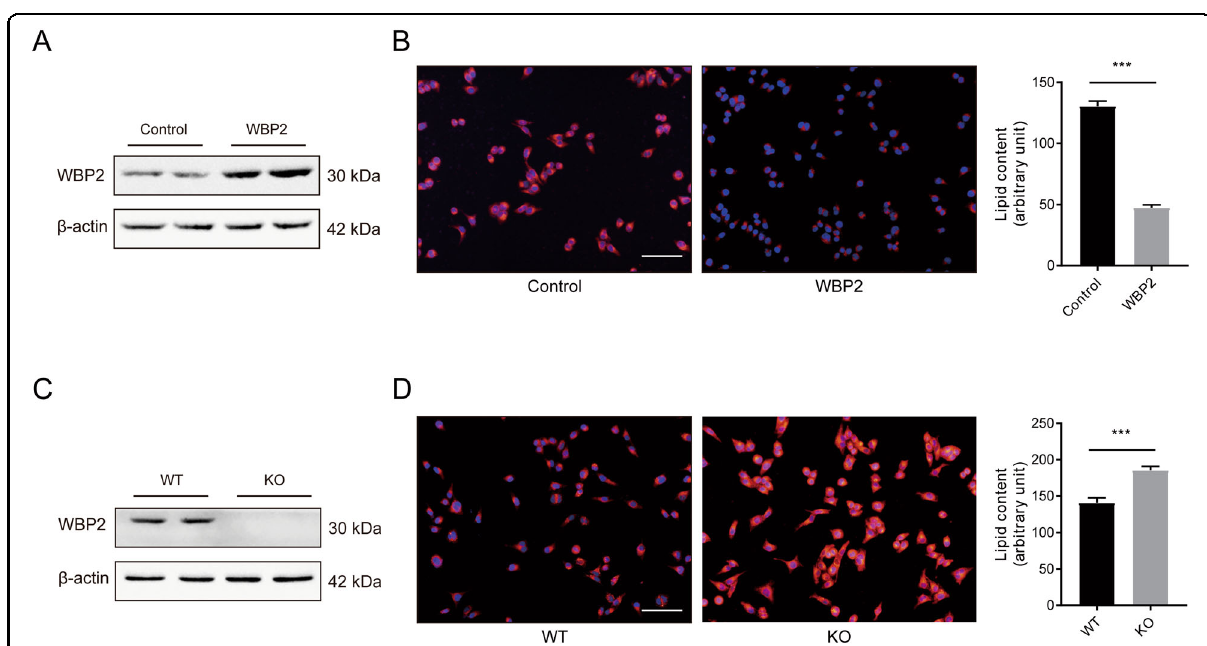
Fig. 2 The effect of WBP2 on lipid deposition in primary hepatocytes stimulated by PA. A , C A WBP2-overexpressing cell line ( A ) and a WBP2 knockout cell line ( C ) were established in LO2 cells. The protein expression of WBP2 was tested by western blot analysis. B Representative photomicrographs with Nile red staining are shown for the control and WBP2-overexpressing cells exposed to PA (0.25 mM) for 12 h. D Representative photomicrographs with Nile red staining are shown for the WT and WBP2 KO cells exposed to PA (0.25 mM) for 12 h. The Nile red- stained area was quanti fi ed by ImageJ software. Scale bar, 100 μ m. Data are expressed as the mean ± SEM, *** P <